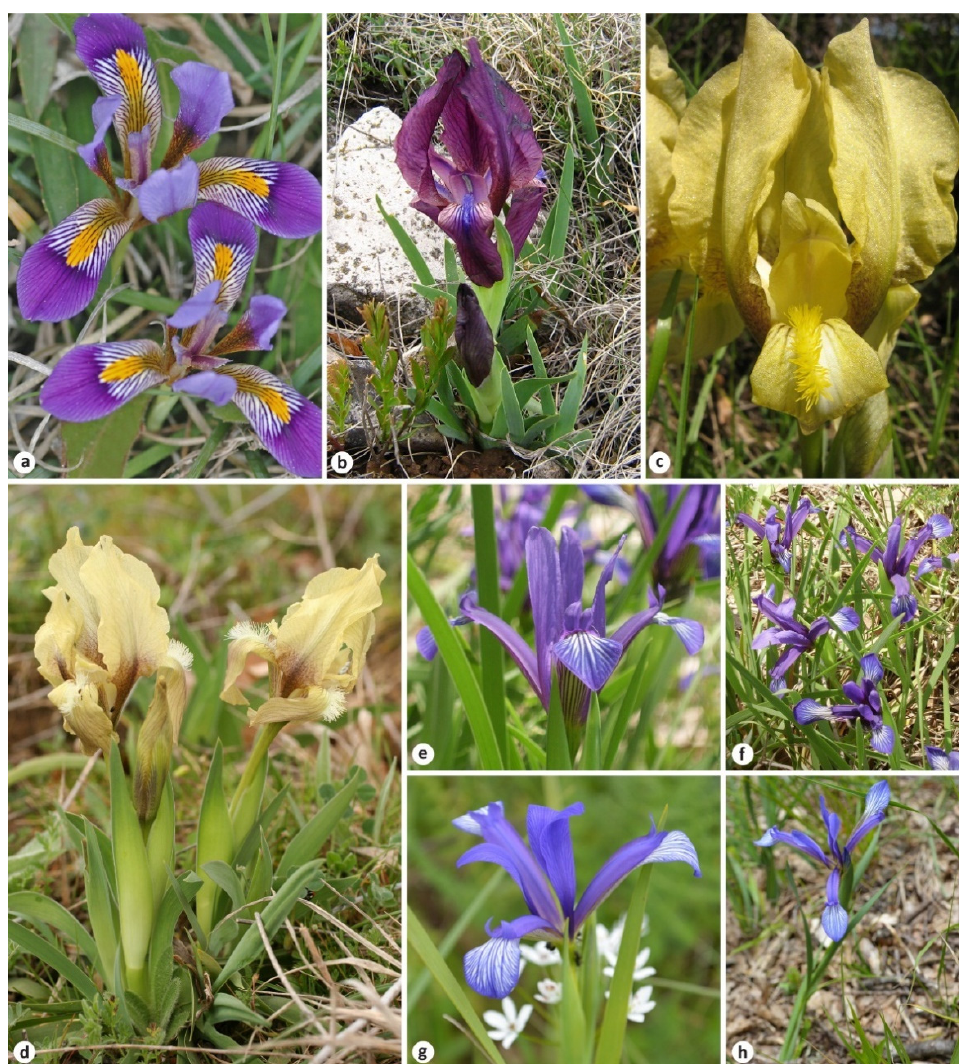
Figure 1. Plants associated with the names described by Victor Janka in Iris : ( a ) I. unguicularis (= I. cretensis ) from Crete (5 km from Spili to Geraki); ( b ) the purple form of I. reichenbachii (= I. balkana ) from Bulgaria (near Kralev Dol Village, Golo Bardo Mountain); ( c ) the typical yellow form of I. reichenbachii (south of Pernik, Golo Bardo Mountain, Bulgaria); ( d ) I. suaveolens (= I. mellita ) from Bulgaria (south of Beloslav); ( e , f ) I. sintenisii from Bulgaria (southwest of Valcha Polyana, Yambol Oblast); ( g , h ) I. sintenisii (= I. lorea ) from southern Italy (near Martina Franca, Taranto Province, Apulia); ( a )—by A. Strid, ( b – f )—by S. Stoyanov, ( g , h )—by R. Labadessa.